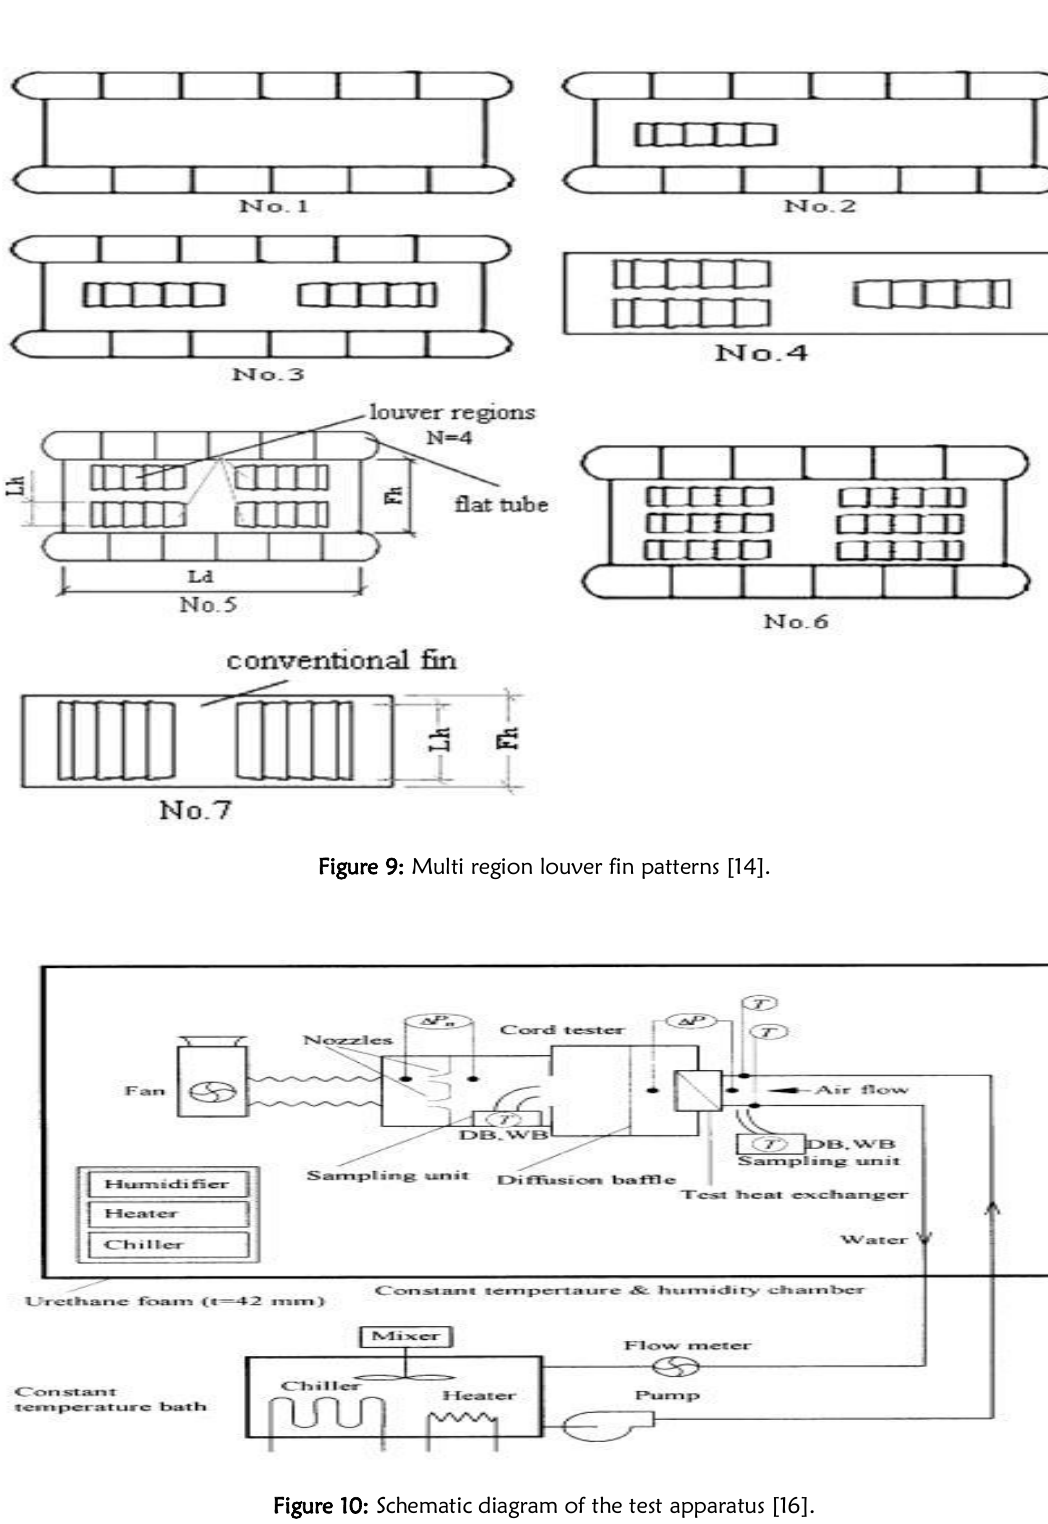
Figure 10: Schematic diagram of the test apparatus